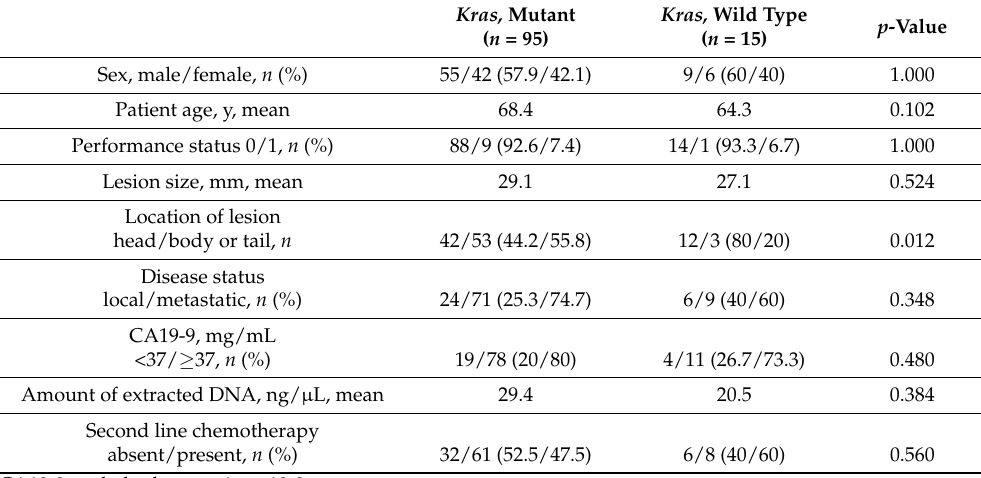
Table 2. Characteristics of patients according to the two groups.